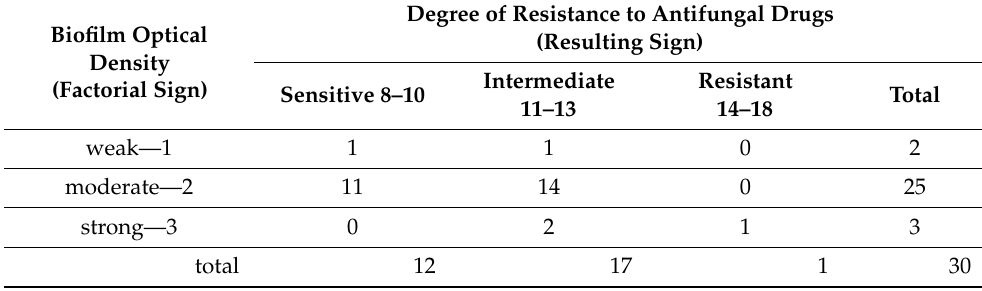
Table 3. The relationship between the ability to form biofilms and resistance to the antifungals (Chi-square statistical